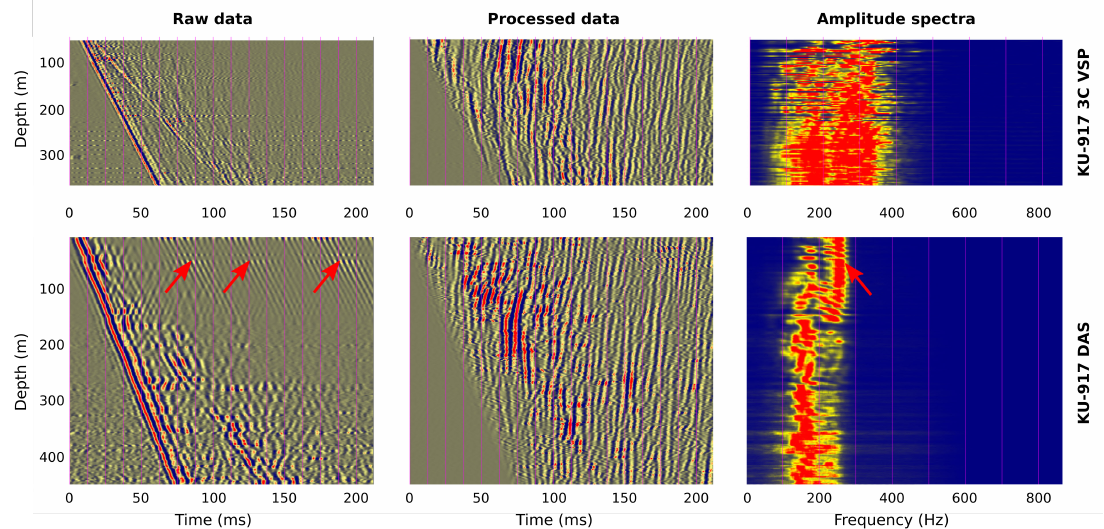
Figure 5. Comparison of conventional 3C geophones (top row) against fiber-optic DAS data (bottom row). The left column shows the raw data. The center column shows the processed data (before migration). The right column shows the amplitude spectra after processing was applied. The Z component (along the borehole) is shown for the 3C raw data and the P-component (particle movement towards the source location) for the processed 3C data. Strain rate is shown for the DAS data. Red arrows indicate noise in the upper part of the fiber-optic cable due to oscillations in the uncemented